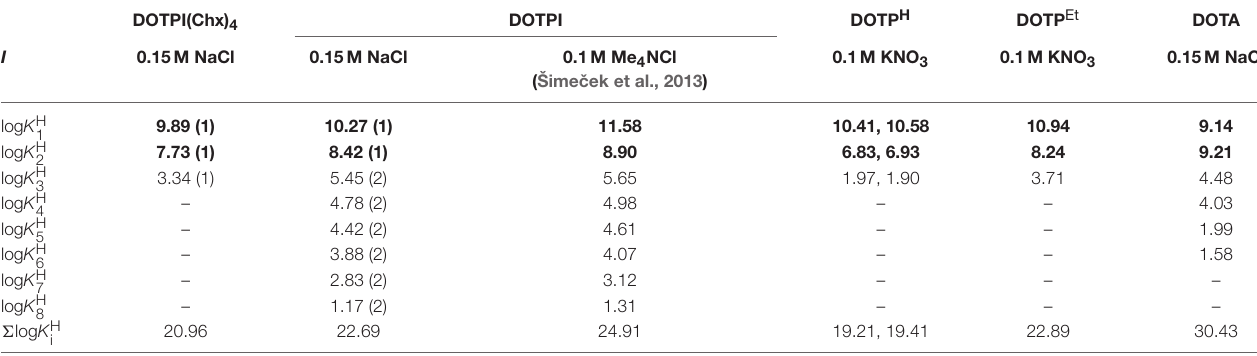
TABLE 1 | Protonation constants of DOTPI(Chx) 4 , DOTPI, DOTP H , DOTP Et , and DOTA at 25 ◦ C (for structures see Figure 1 ).